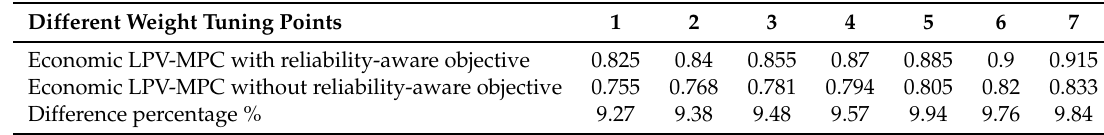
Figure 12. Evaluation of system reliability and accumulated economic cost. Table 6. Final system